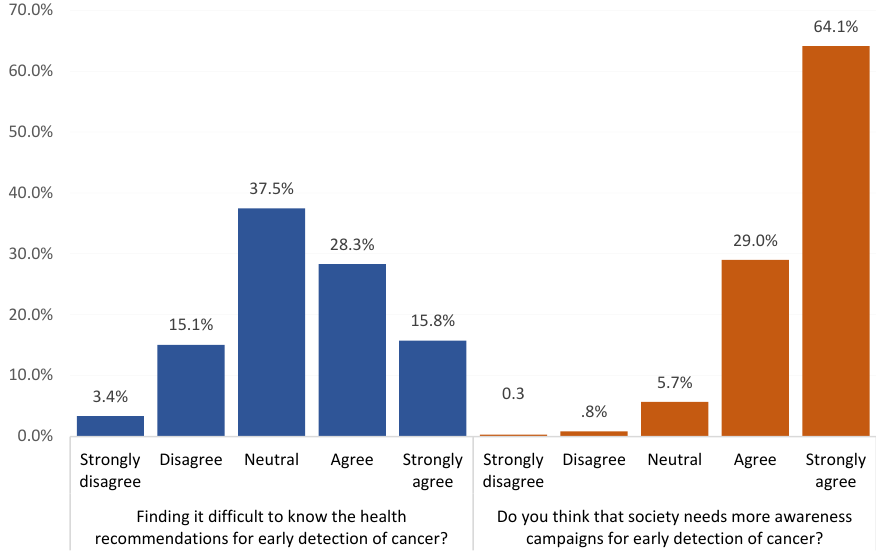
Figure 3. Participants’ attitude s towards cancer screening, Saudi Arabia.